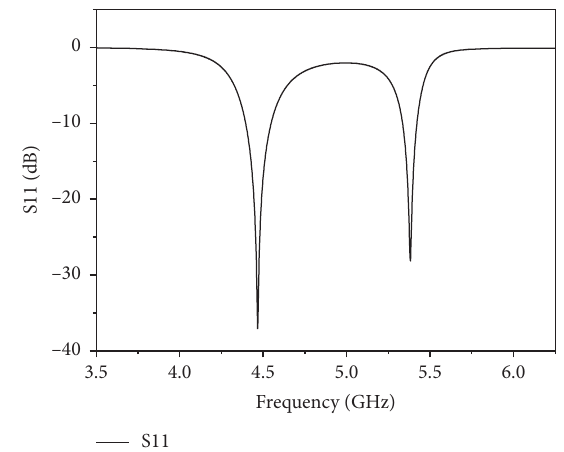
Figure 3: Simulated reflection coefficient of the proposed dual-band